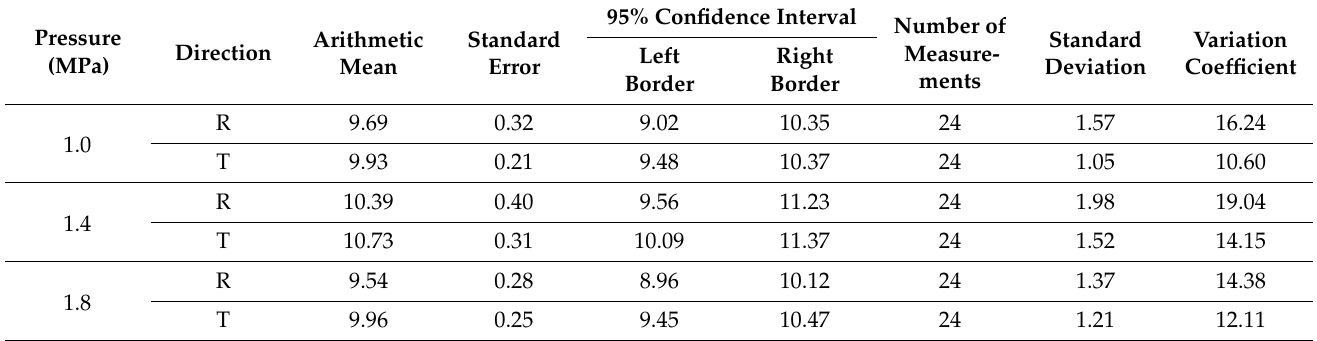
Table 6. Statistical characteristics during contact drying—impact toughness.